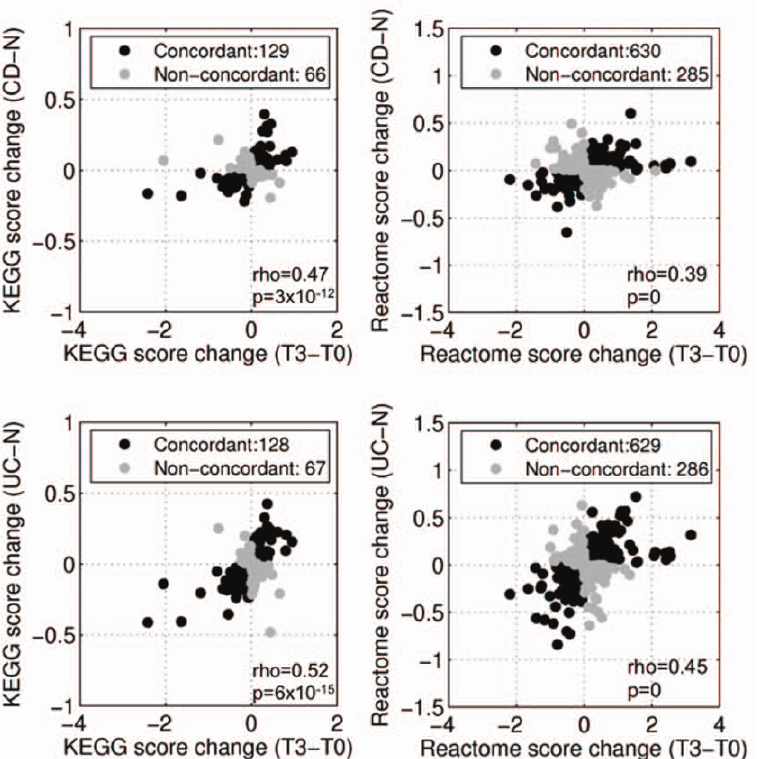
Figure 7. Concordance analysis between TNBS-colitis and IBD transcriptomes at the level of biological pathways. T3 vs. T0 compared to CD vs. normal (top) and UC vs. normal (bottom). Left, scatter plots of pathway activity scores of KEGG pathways in TNBS and IBD samples. Right, scatter plots of pathway activity scores of Reactome pathways in TNBS and IBD samples. Rho values correspond to Spearman correlation coefficients with p -values representing the level of significance of the correlation. Numbers in the legend correspond to the total number of pathways assigned to each category. A similar figure (Figure S2) for concordant analysis of T7 vs. T0 and T12 vs. T0 , compared to CD vs. normal and UC vs. normal is shown in the supplementary section (KEGG and Reactome score change at the top and bottom, for T7 vs. T0 and T12 vs. T0, respectively).